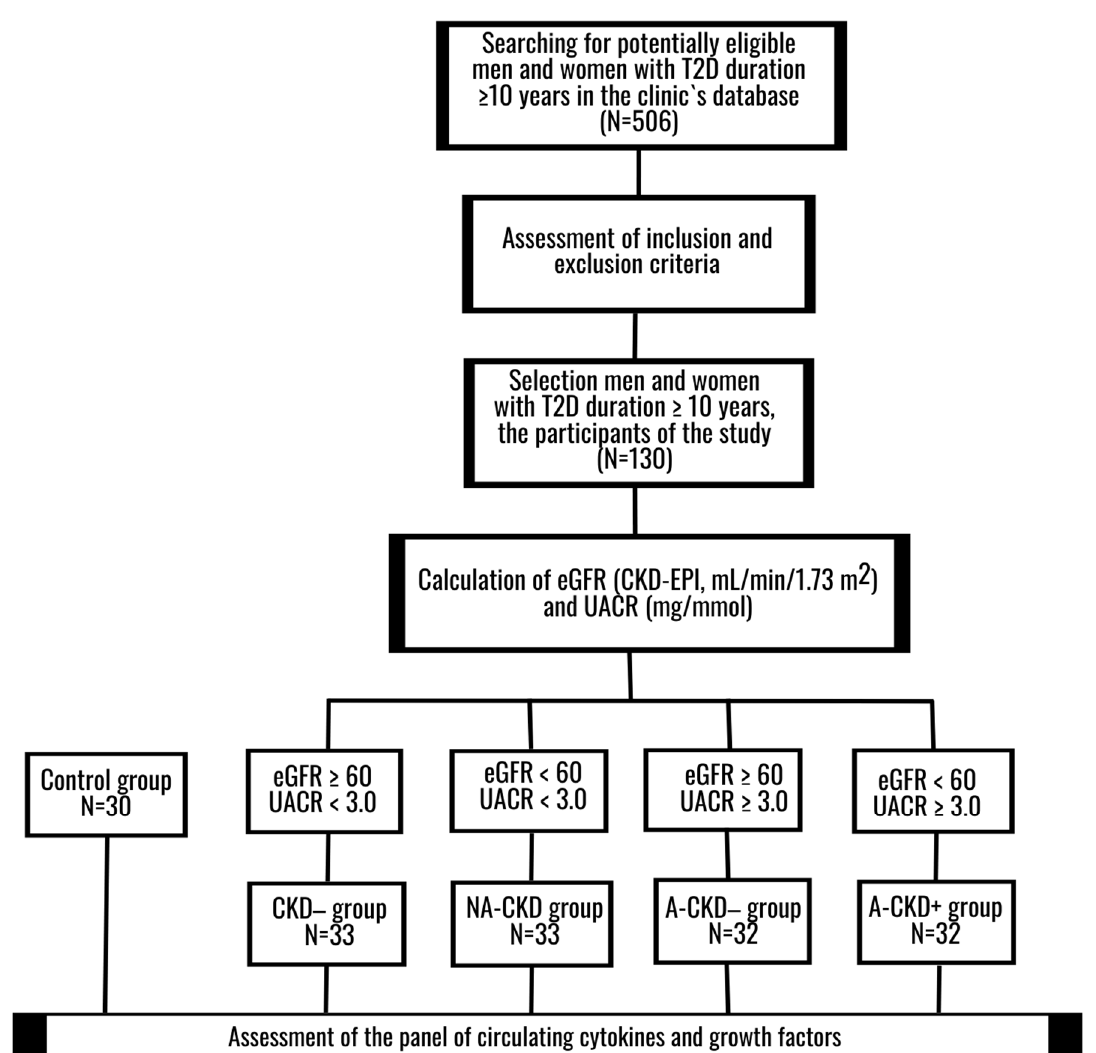
Figure 1. The study design. The panel of circulating cytokines and growth factors was assessed in fourgroups of T2D patients and healthy controls. CKD − : group of patients with estimated glomerular filtration rate (eGFR) ≥ 60 mL / min / 1.73 m 2 and urinary albumin-to-creatinine ratio (UACR) < 3.0 mg / mmol; NA-CKD: non-albuminuric chronic kidney disease, group of patients with eGFR < 60 mL / min × 1.73 m 2 and UACR < 3.0 mg / mmol; A-CKD − : group of patients with albuminuria (UACR ≥ 3.0 mg / mmol) and eGFR ≥ 60 mL / min / 1.73 m 2 ; A-CKD + : albuminuric chronic kidney disease, group of patients with eGFR < 60 mL / min / 1.73 m 2 and UACR ≥ 3.0 mg / mmol; eGFR, estimated glomerular filtration rate; T2D, type 2 diabetes; UACR, urinary albumin-to-creatinine